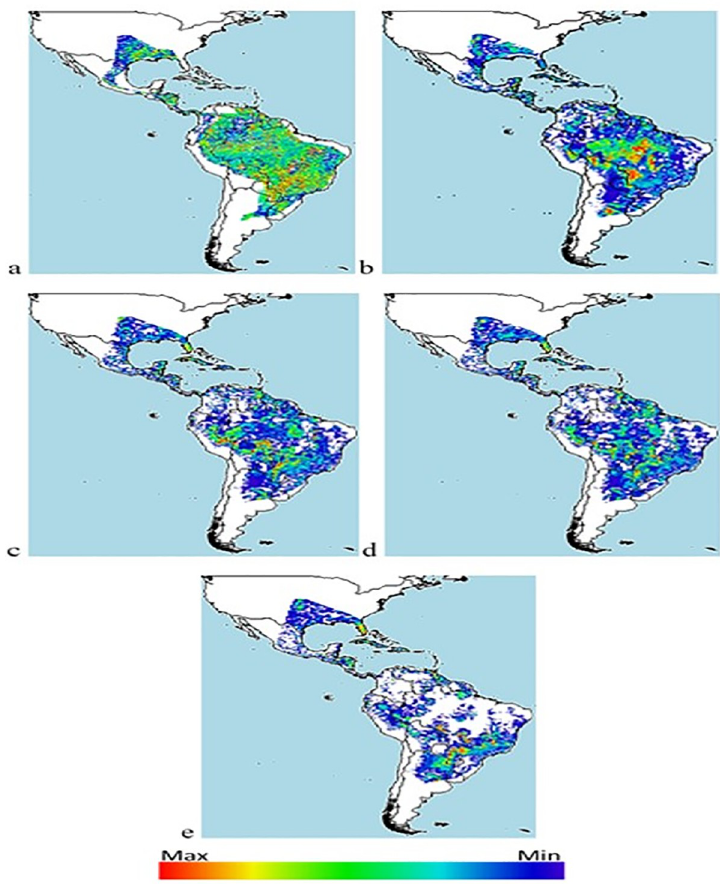
Fig 9. Distribution of Diatraea spp. in the Western Hemisphere under different climate change (BCC-CSM1-1) and carbon concentration projections over 70 years. a) current condition, b) rcp26, c) rcp45, d) rcp60, e) rcp85. Color indicates maximum or minimum presence in a likely niche and under favorable